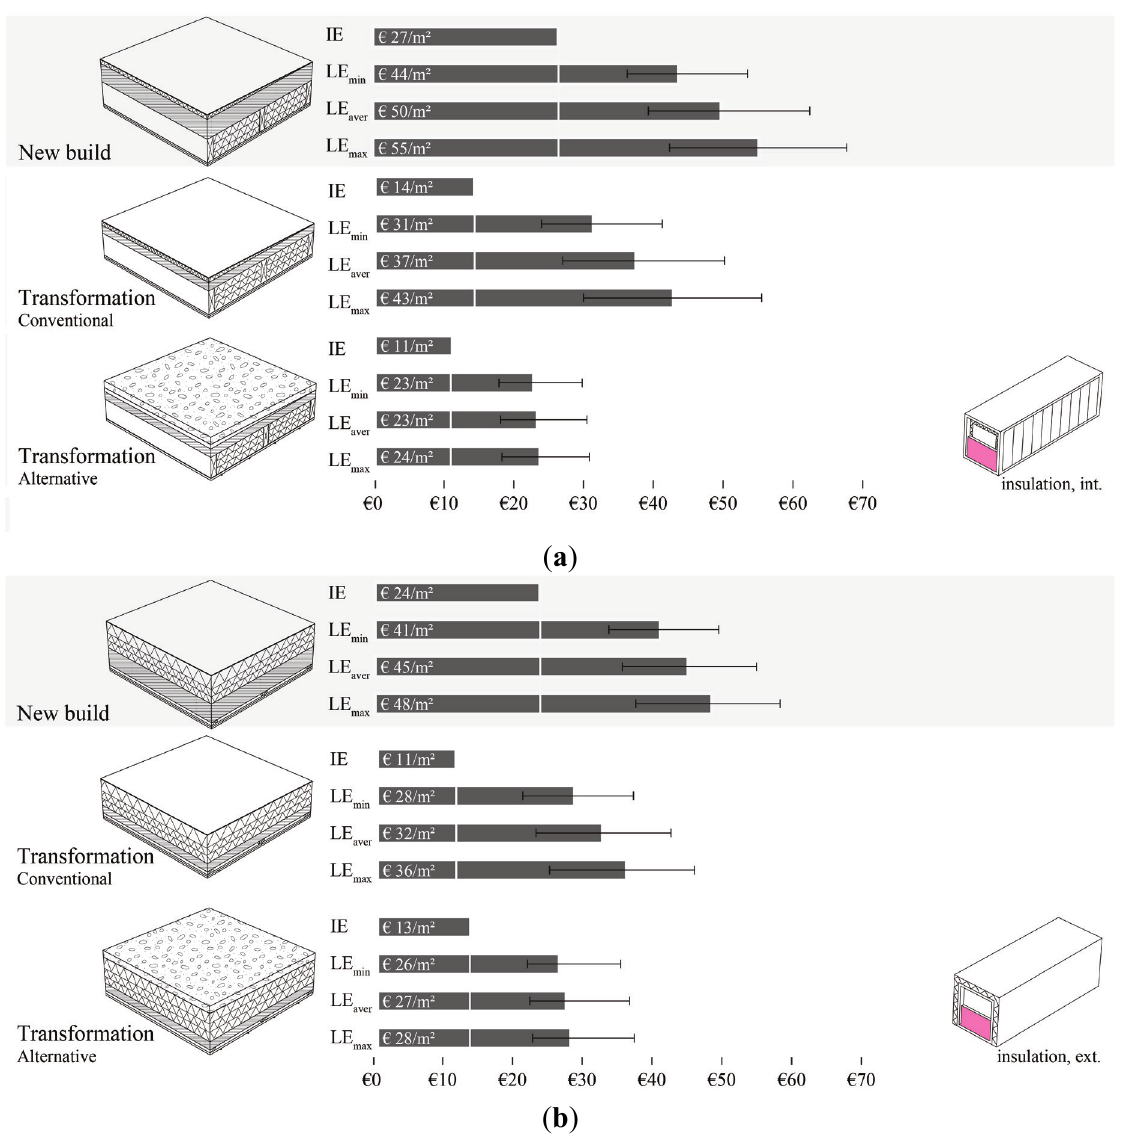
Figure 7. Based on the outcomes of life cycle assessments of the roof, with ( a ) internal or ( b ) external insulation, the conclusions are similar for both cases again: transformation with demountable elements has the lowest life cycle impact. With IE as initial environmental impact, LE min as life cycle impact with no refurbishments, LE aver as life cycle impact with an average number of refurbishments, LE max as life cycle impact with a maximum number of refurbishments during 60 years, the error bars represent the results of the sensitivity analysis on a variable lifespan of the building (from 30 to 79